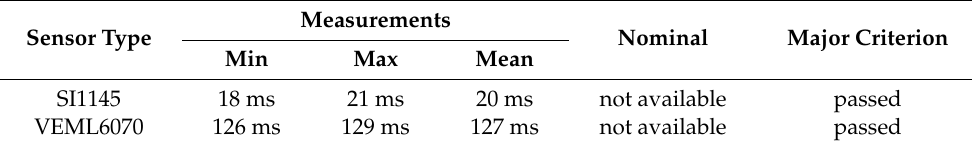
Table 11. Comparison of response time (in ms) of UV index sensors.